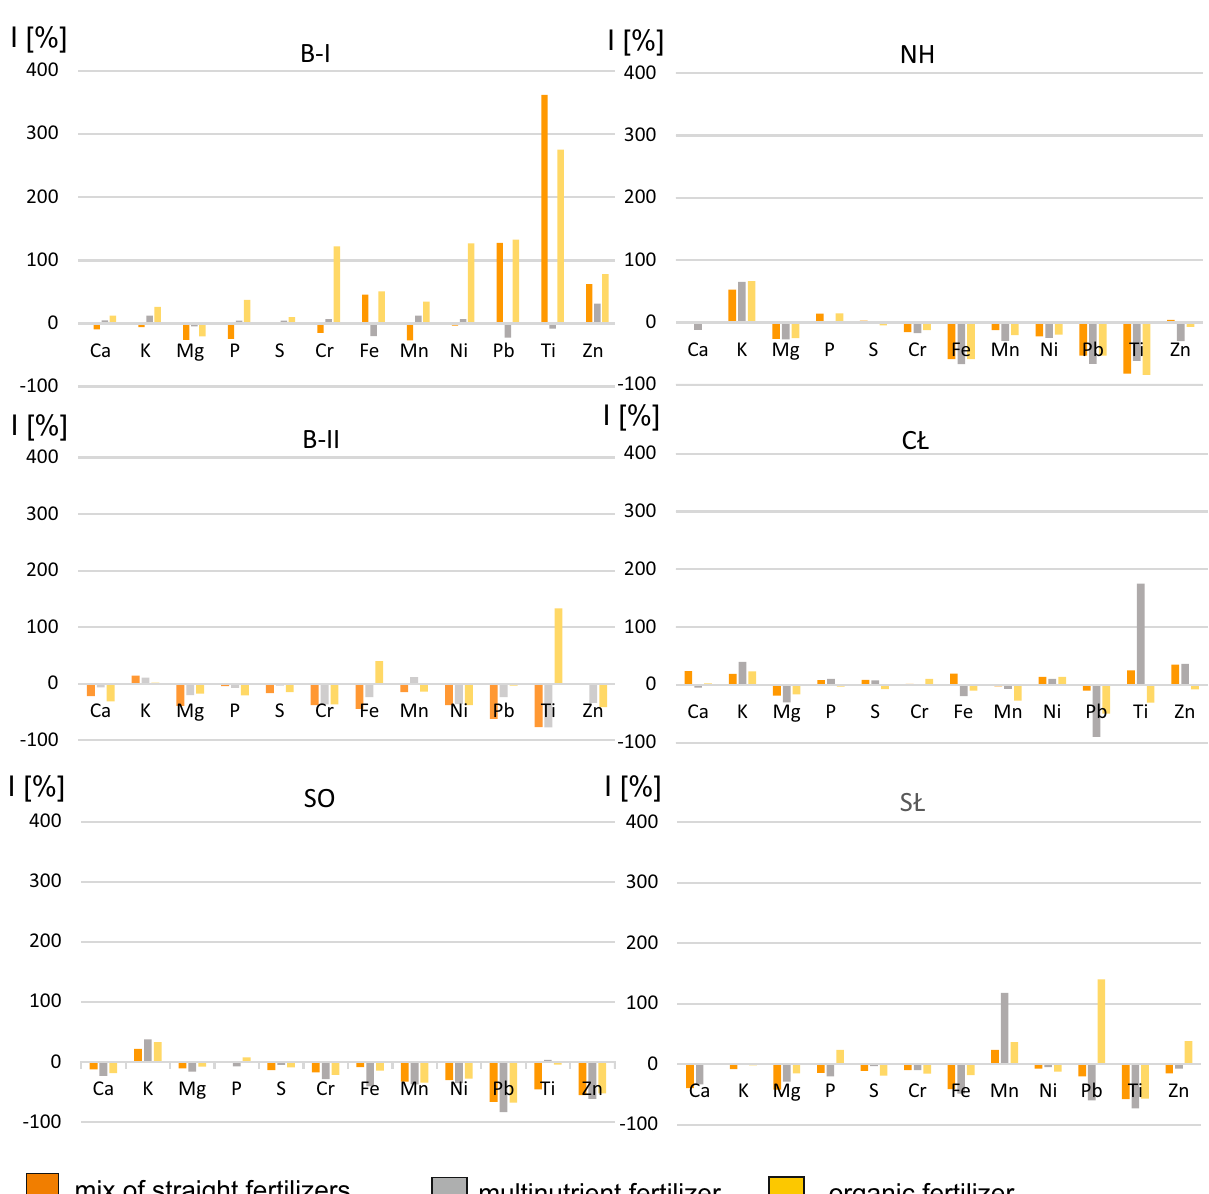
Figure 8. Inhibition rates (I) of macro- and microelements content in lettuce after applying various types of fertilization. B-I, B-II—Bukowno region, SO—Sosnowiec, NH, CŁ—Nowa Huta region, SŁ—control